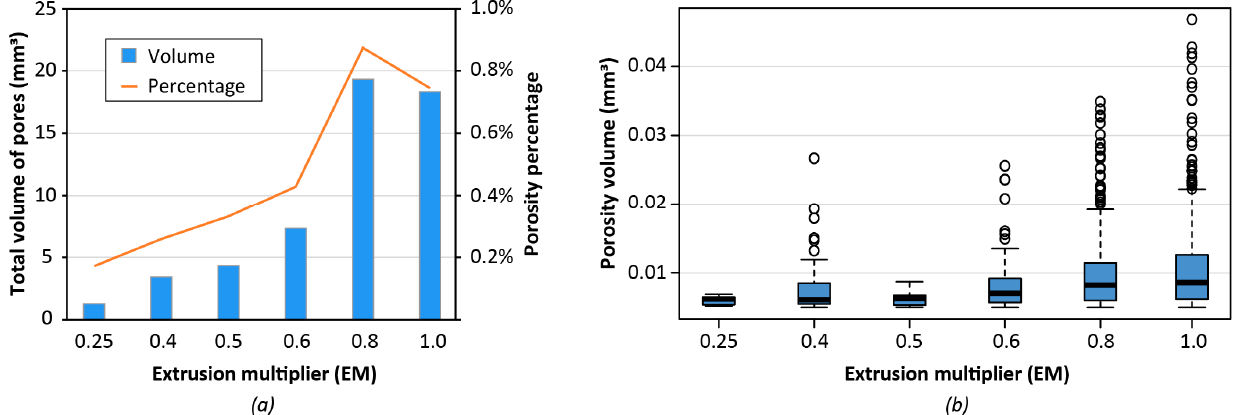
Figure 6. Porosity analysis of hollow test cubes 3D printed with different Extrusion Multiplier (EM) values: ( a ) total volume of pores for different values of EM; ( b ) distribution of porosity volume at varying EM (excluding pores with volume lower than 0.005 mm 3 and higher than the 99th percen- tile).